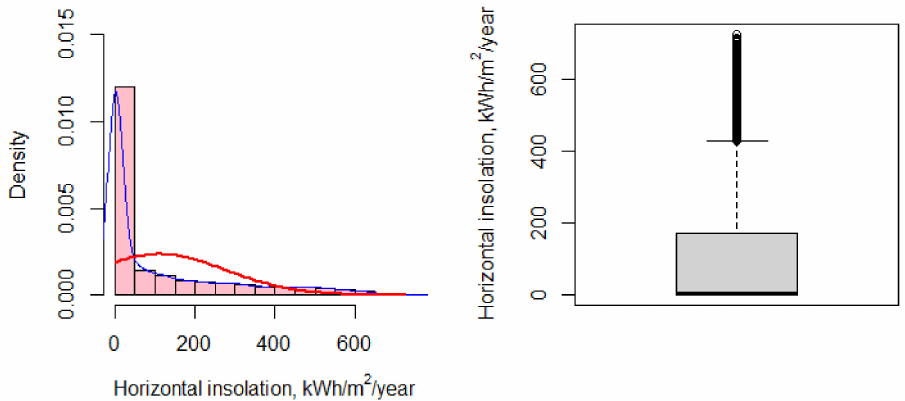
Figure 13. The graphical representation of the distribution of hourly insolation in the horizontal location of the M4 object. Source: own study in RStudio environment based on ERA5-Land